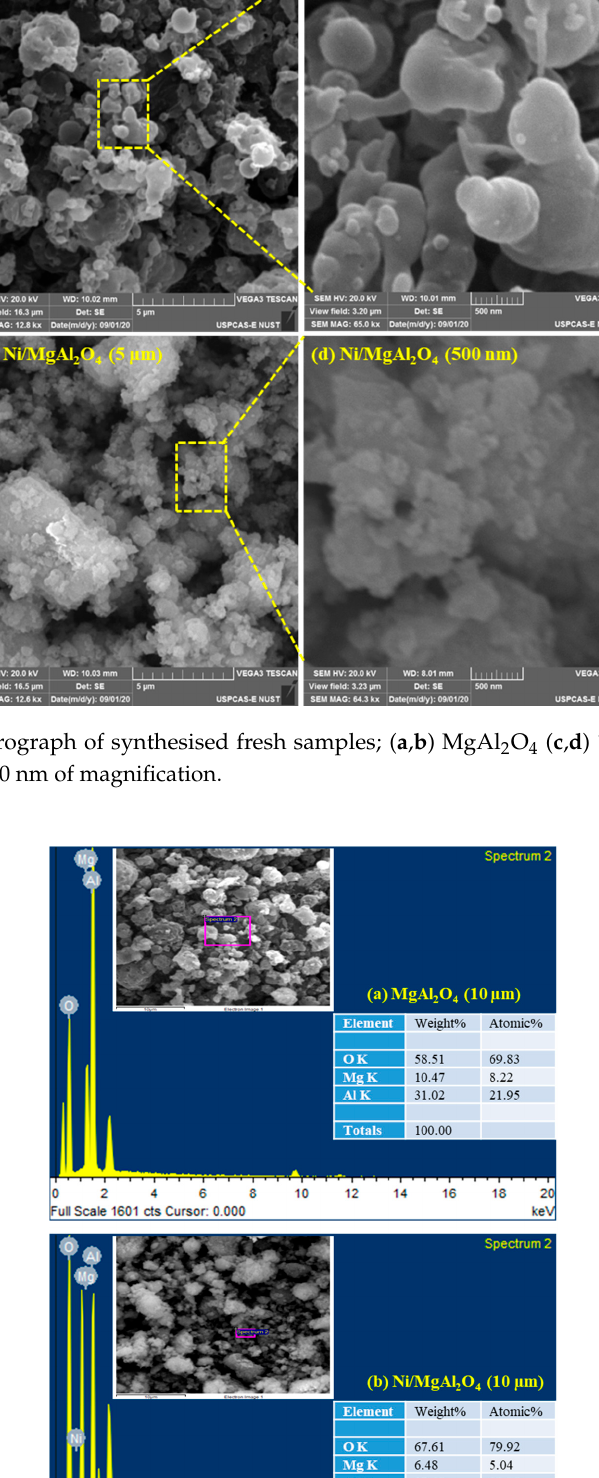
Figure 6. TGA analysis of fresh 10 wt% Ni/MgAl 2 O 4.